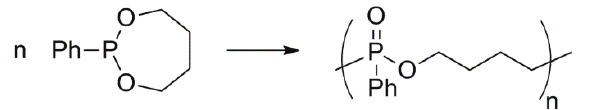
Figure 62. Electrophilic ring-opening polymerization of a cyclic